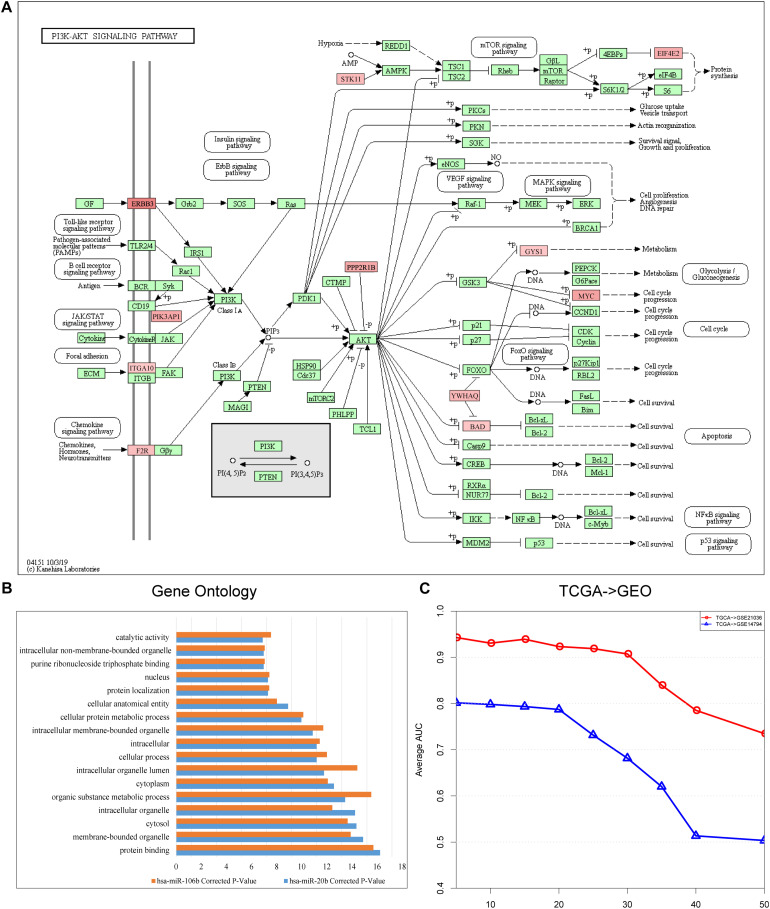
(A) Landscape of PI3K-Akt signaling pathway (hsa04151). Red represents the target genes of hsa-miR-106b, and the intensity of red represents the level of differential expression. (B) Shared Gene Ontology (GO) terms of the target genes of hsa-miR-106b and hsa-miR-20b obtained by using KOBAS 3.0. (C) Line graph indicating the importance of the topological information. The x-axis refers to the percentage of deleted miRNA–target gene pairs; the y-axis refers to the corresponding AUCs.